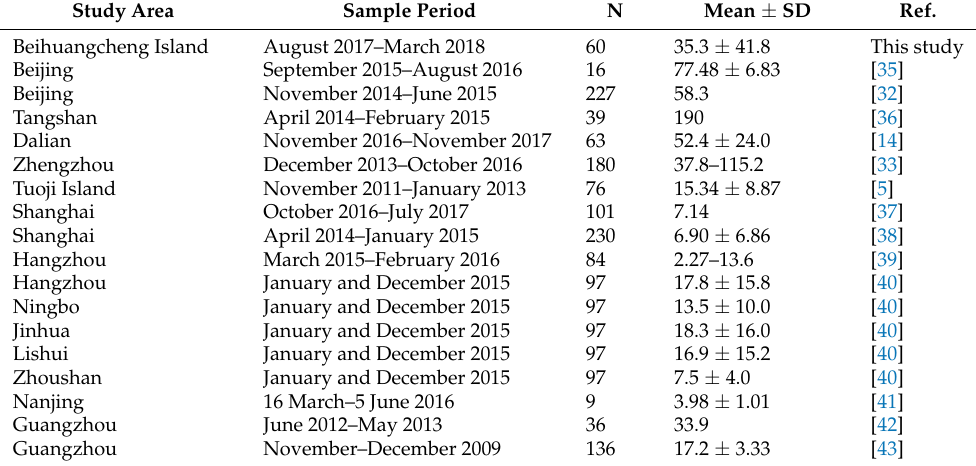
Table 3. PM 2.5 -bound PAH concentrations in this study and previous studies (unit: ng/m 3 ). Study Area Sample Period N Mean ± SD